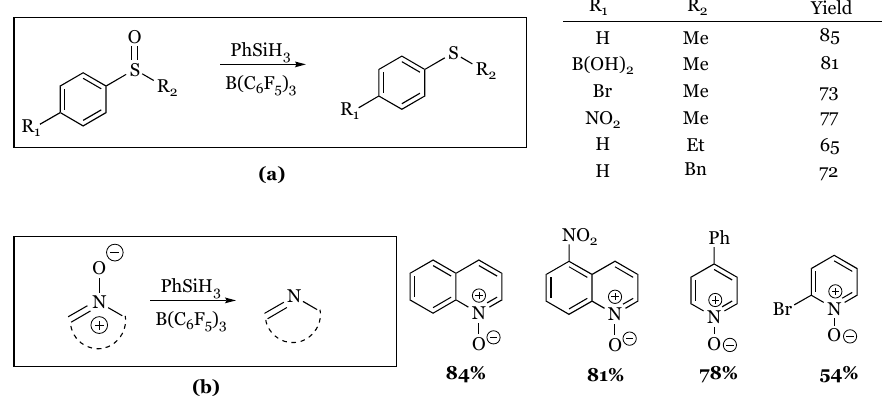
Figure 17. Deoxygenation of sulfoxides and amine N -oxides: ( a ) Aryl sulfoxides; ( b ) Aryl-N-oxides.